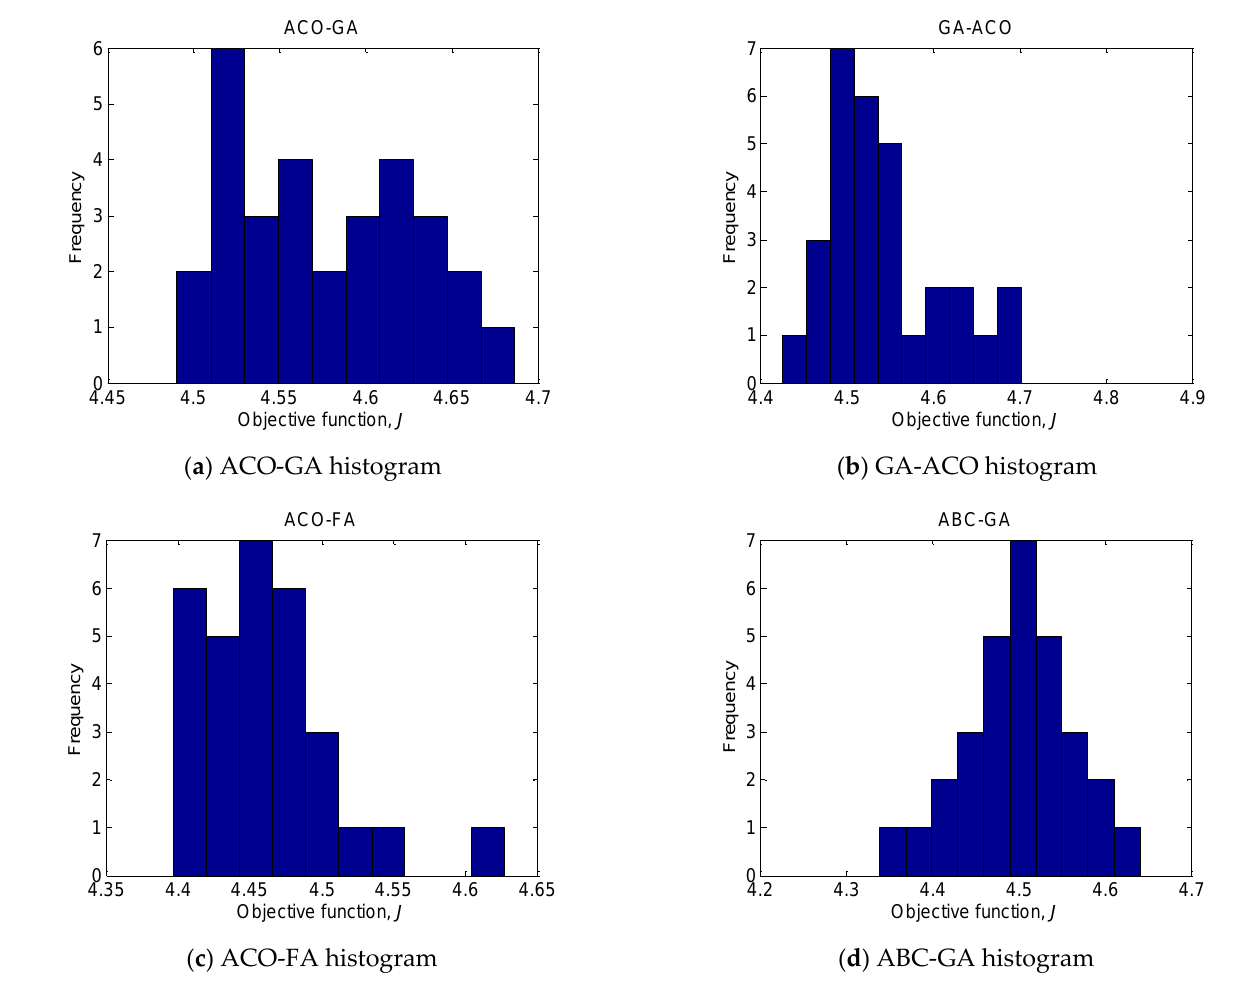
Figure 5. Histograms of the results of objective function values of 30 runs.